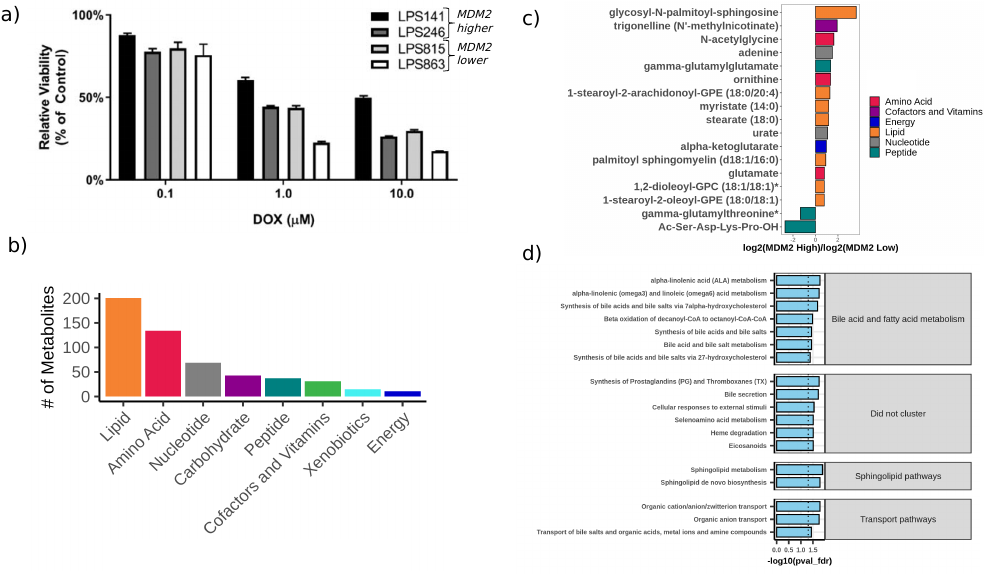
Figure 1. DDLPS cell lines with higher or lower MDM2 amplification show distinct chemosensitivity and metabolomic profiling. ( a ) Cell viability of DDLPS cell lines is elevated in MDM2 higher cells after doxorubicin treatment, ( b ) Distribution of metabolite classes (Metabolon superpathway) represented in the Metabolon panel. ( c ) Metabolites that are altered between MDM2 higher and lower amplification cell lines (FDR-adjusted p -value < 0.05 and |log2 fold change| > 0.75). ( d ) Over-represented pathways (FDR-adjusted p -value < 0.05) in metabolites that are altered between cells with higher vs. lower MDM2 amplification in the blue module of the final network enrichment model (Figure S1c).